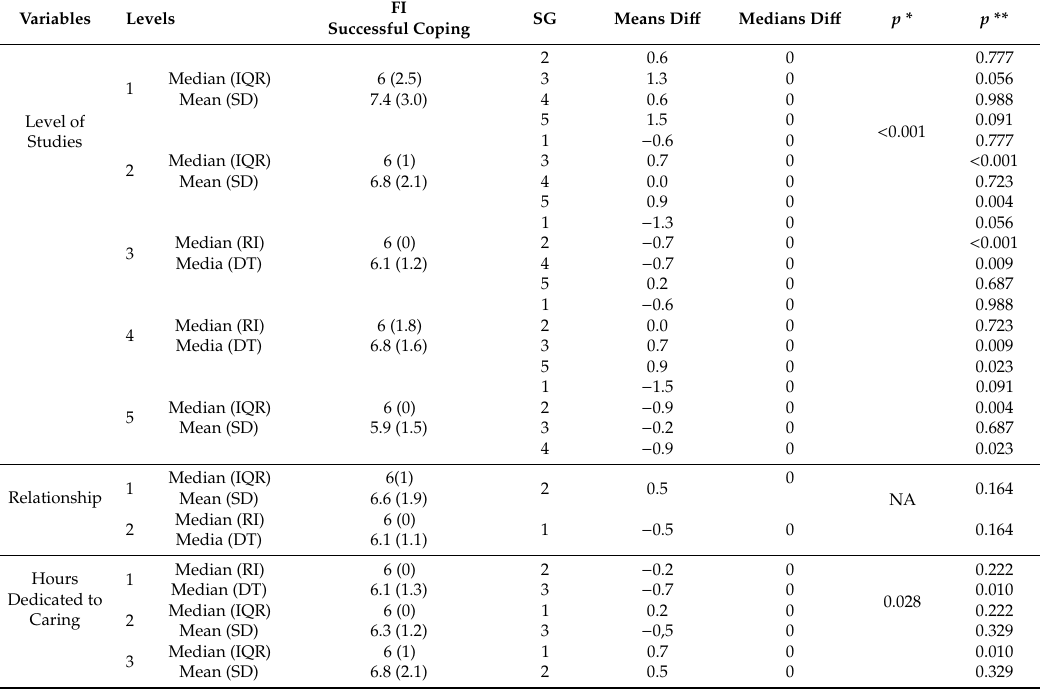
Table 3. Comparison of Factor I “Successful Coping” according to the level of studies, relationship and hours dedicated to caring.